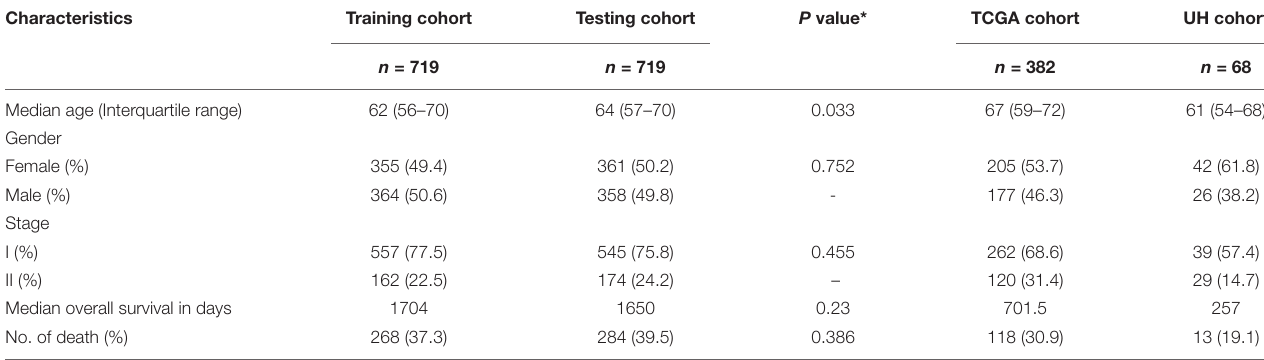
TABLE 4 | Clinical characteristics of patients enrolled in this study.